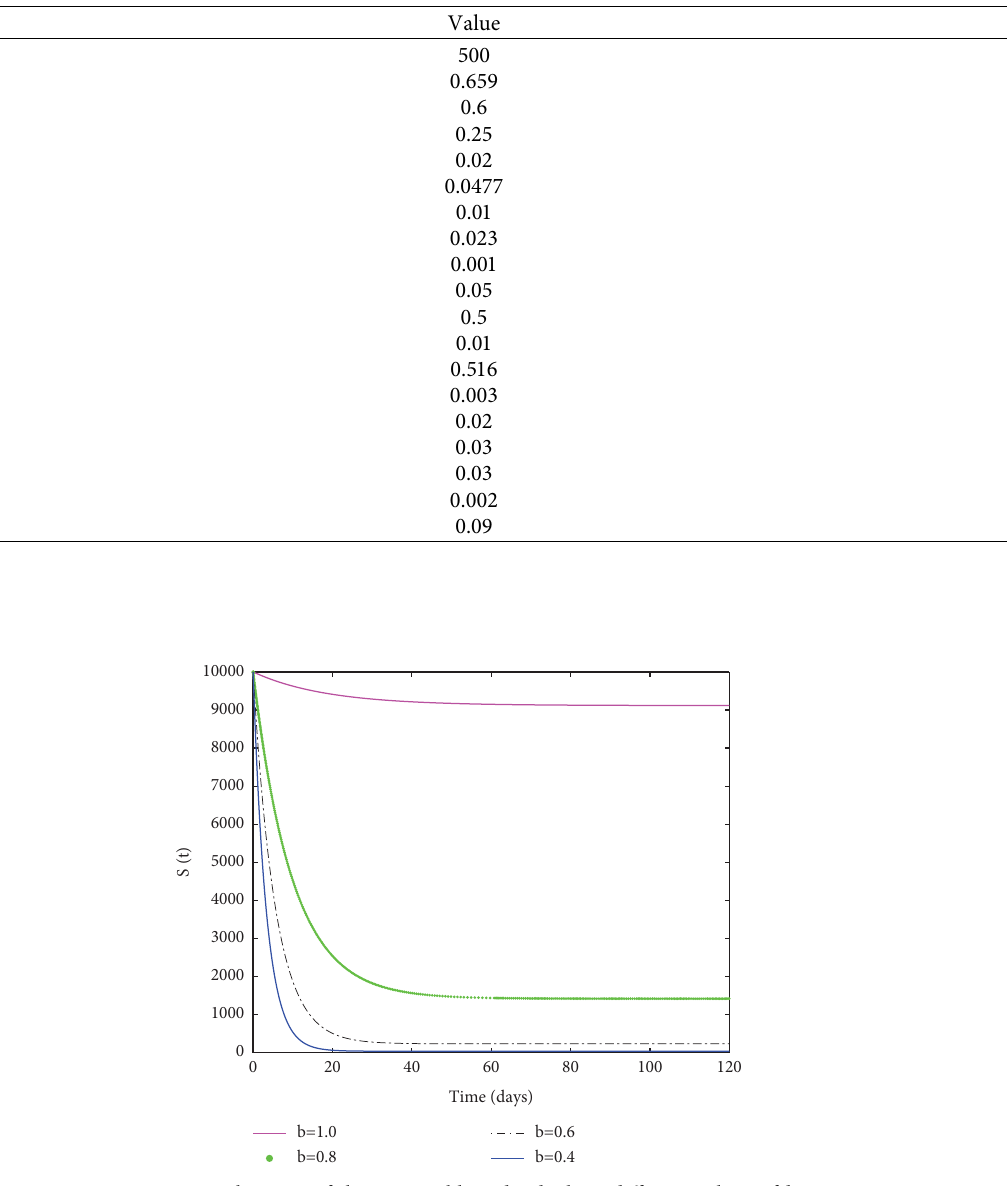
Table 2: Parameter values.